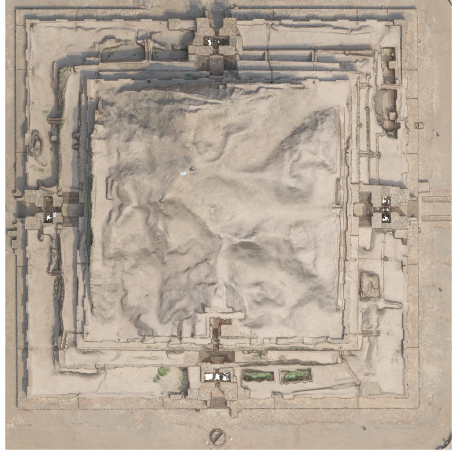
Figure 11. Top view of the NUAV dense point cloud.